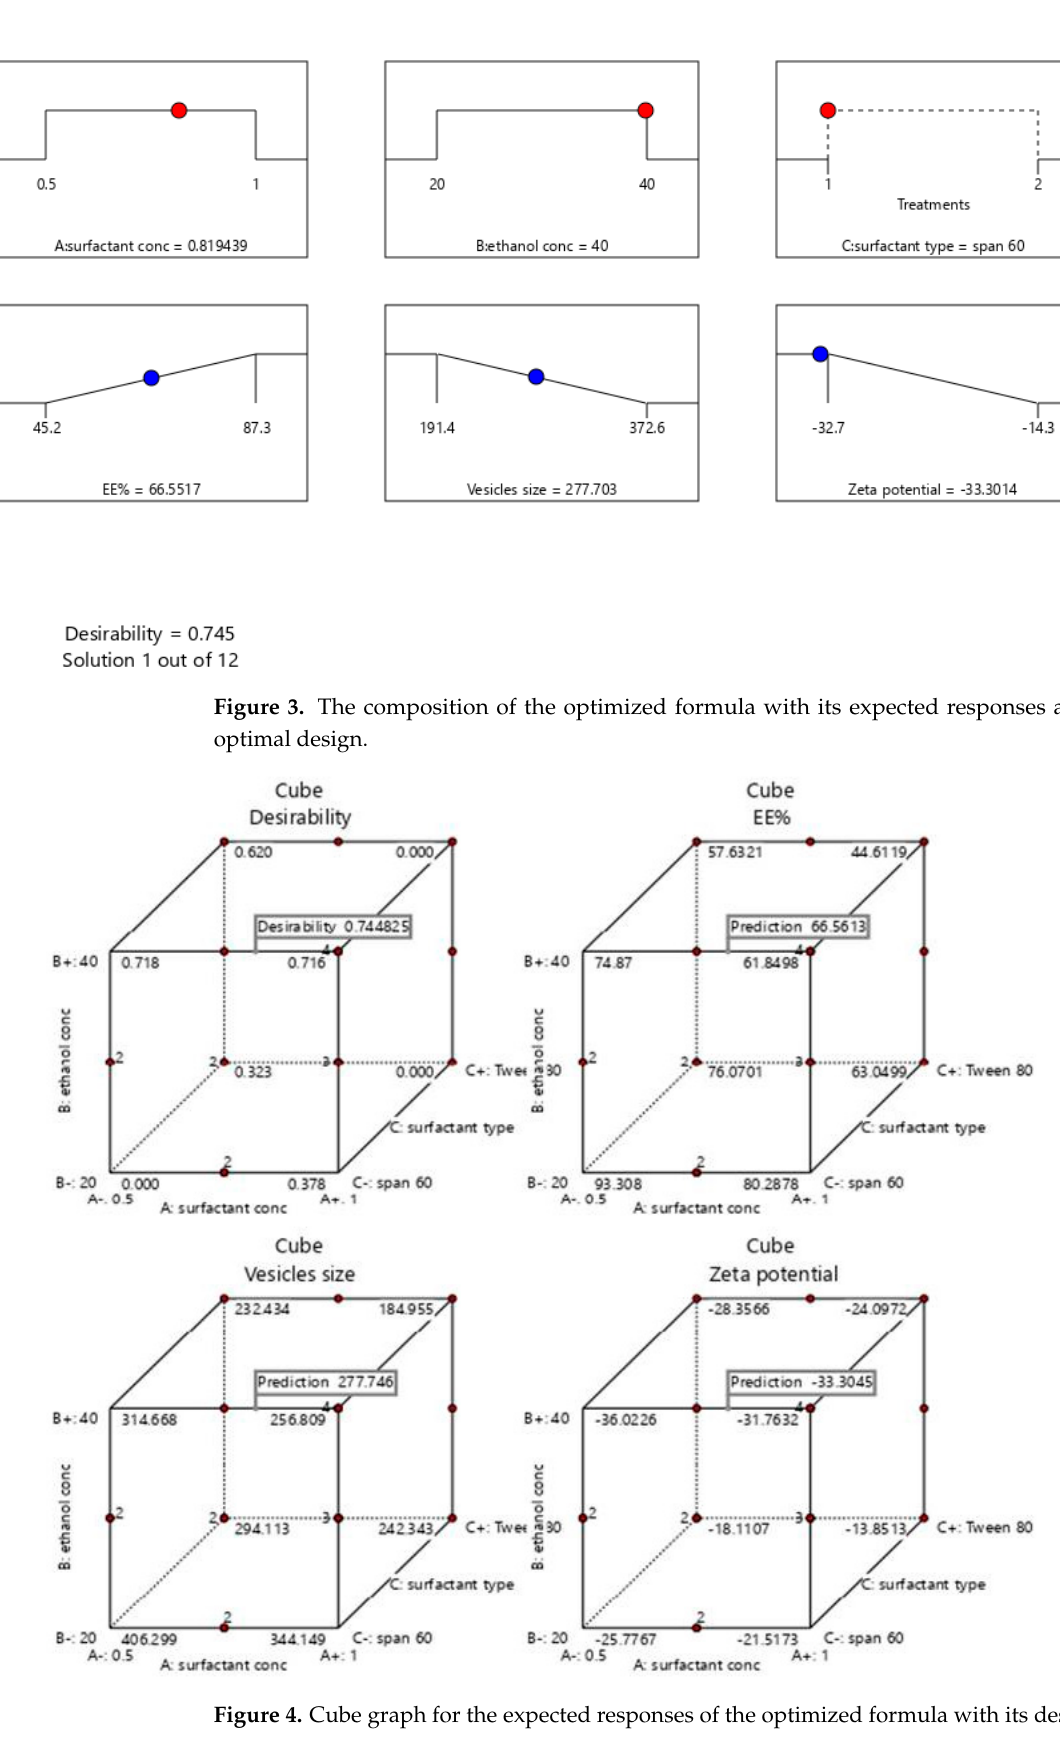
Figure 4. Cube graph for the expected responses of the optimized formula with its desirability.